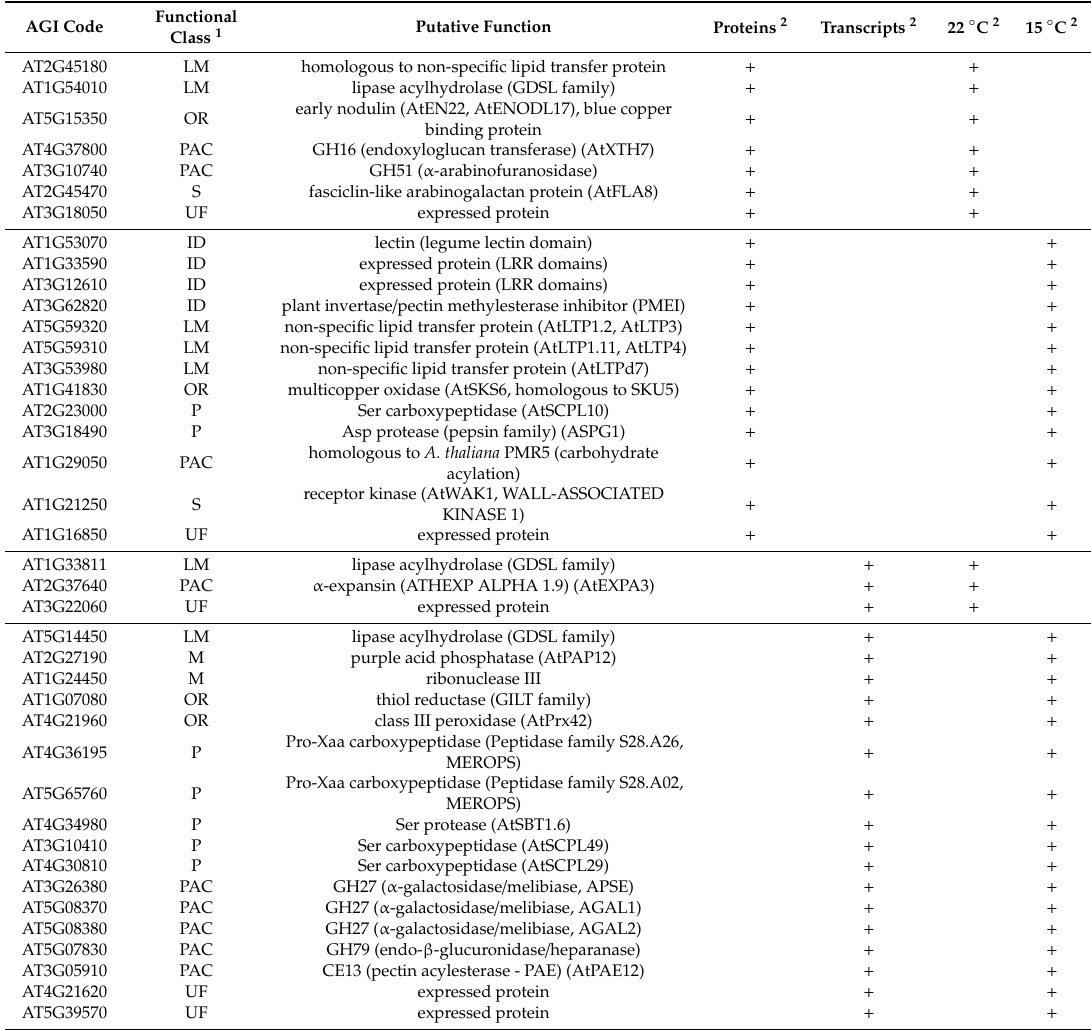
Table 2. Synopsis of CW proteins (CWPs) or CW transcripts di ff erentially accumulated at a given growth temperature in